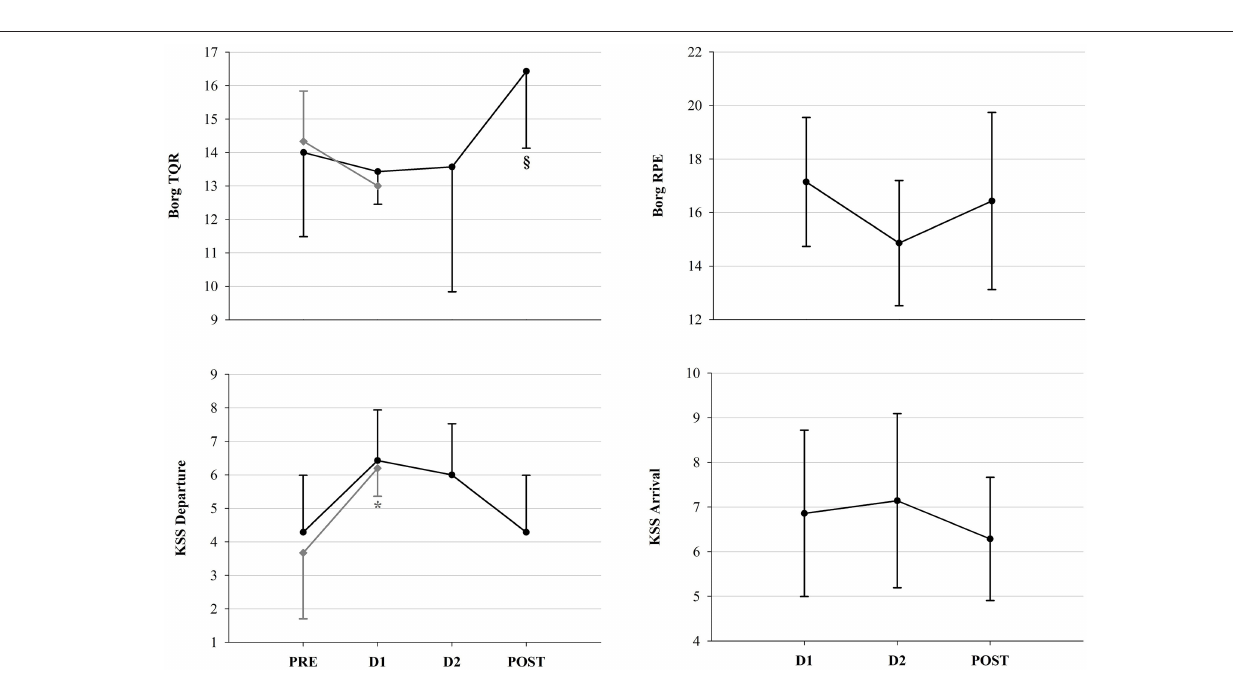
autonomic cardiac modulation and psychometric aspects: strenuous exercise, living outdoors in subarctic winter and sleep